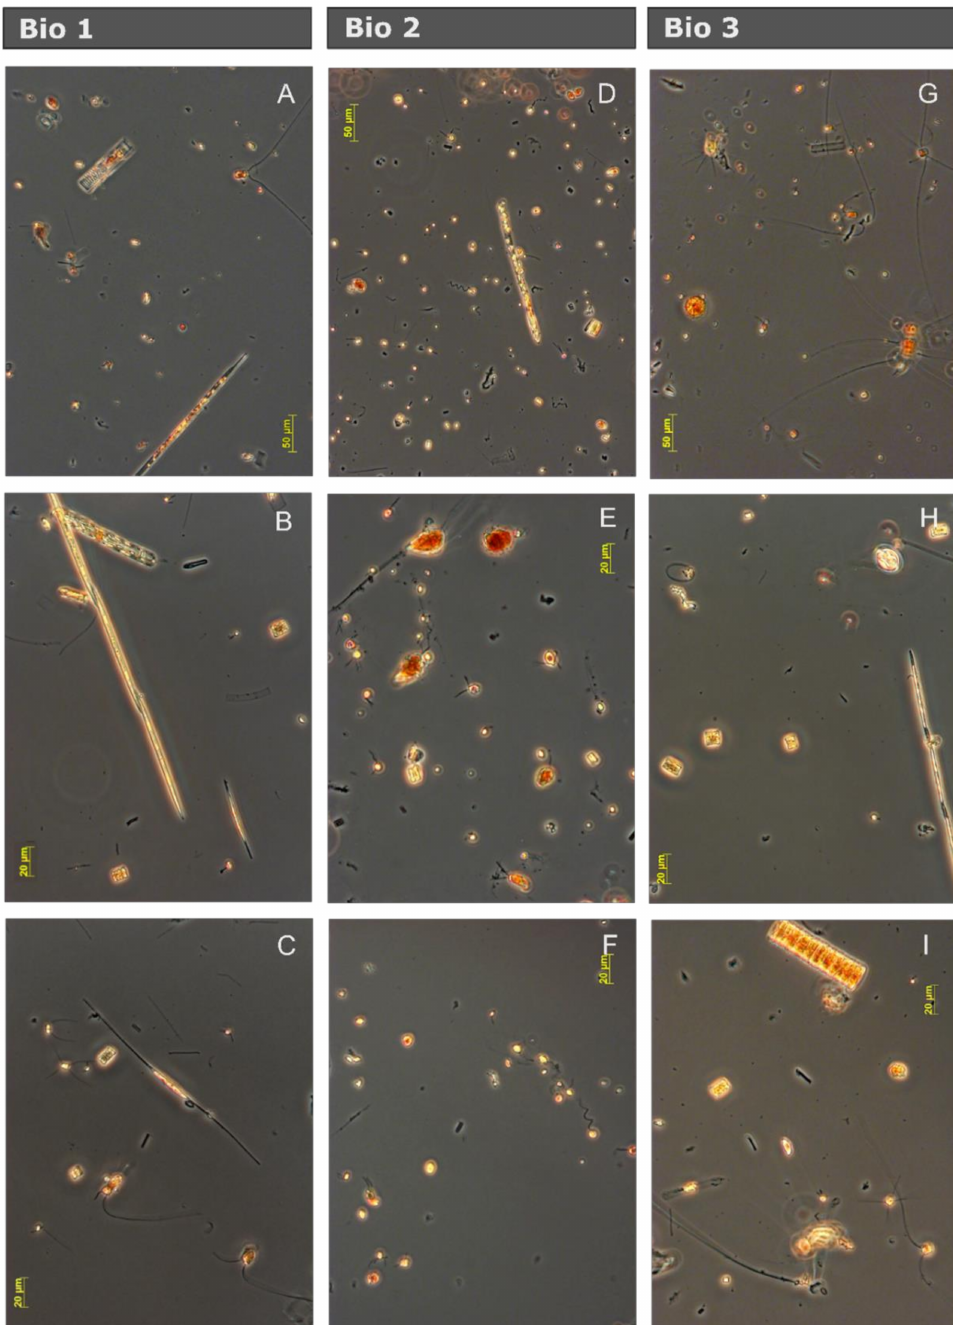
Figure 2. Photographs from the three natural communities of the Drake Passage and the Western Antarctic Peninsula after six days of incubation in seawater from the control treatments using inverted light microscopy. ( A – C ) Bio 1 community, dominated by diatoms and sporadic presence of small flagellates. ( D – F ) Bio 2 community, dominated by small flagellate and with abundant representation of dinoflagellates and small diatoms, and ( G – I ) Bio 3 community, similar to Bio